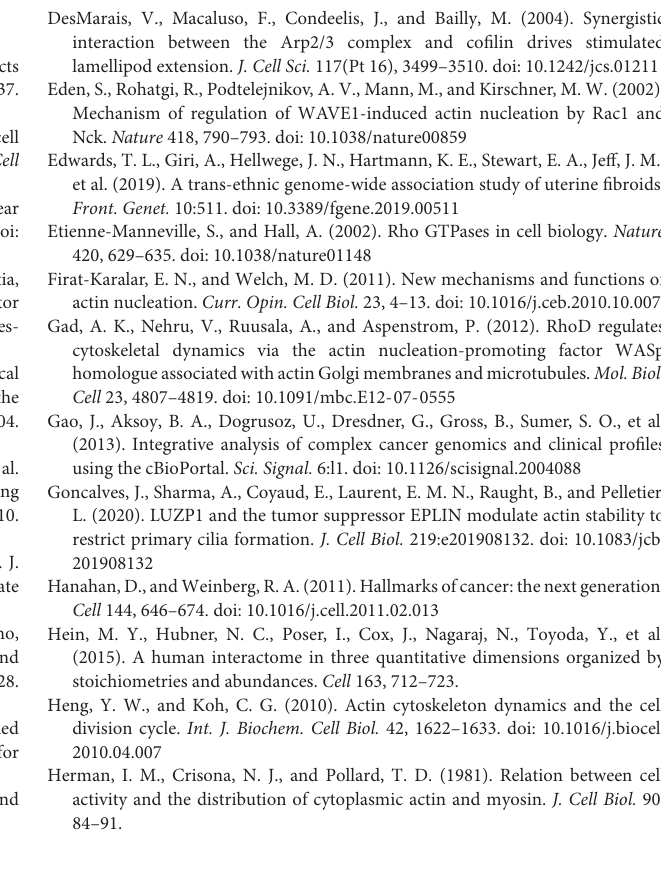
Supplementary Figure 1 | LUZP1 knockout cells display more filopodia and more apoptosis than control. (A) Micrographs of representative individual WT and Luzp1 − / − cells used for Figure 2F . Filopodia were detected by WGA (magenta), F-actin by phalloidin (green) and nuclei by DAPI (blue). Yellow arrowheads point at regions containing filopodia. Black and white images show the single green and magenta channels. Scale bar, 2.5 µ m. (B) Representative profiles of FACS analysis of apoptosis in WT and Luzp1 − / − cells analyzed in Figure 3C . Q2 and Q4 point at early and late apoptosis cells (blue and purple dots,